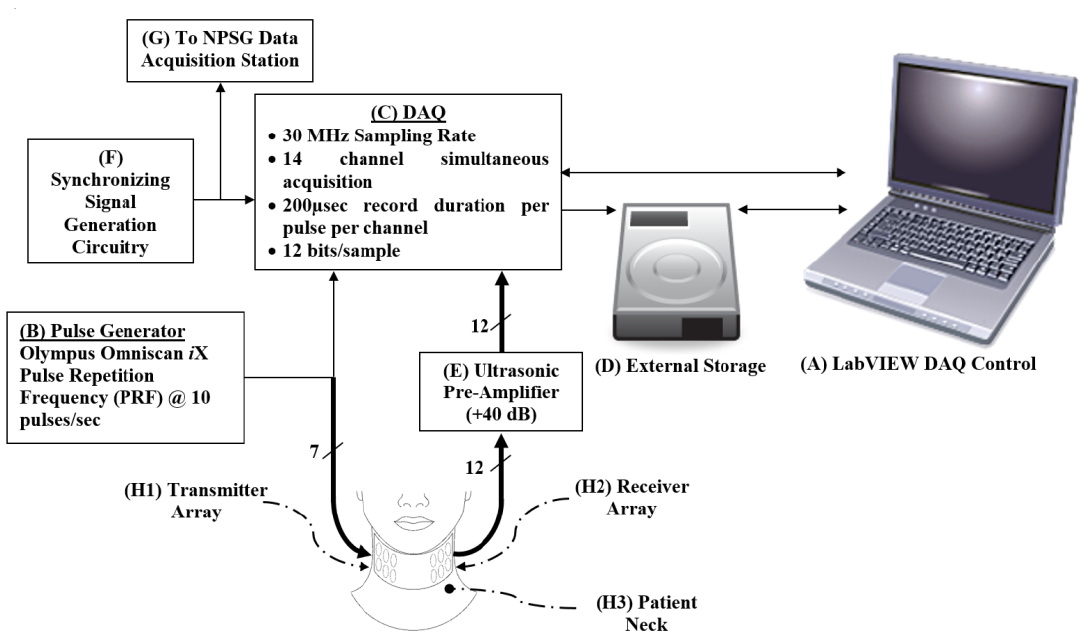
Figure 1. Schematic showing the hierarchy, control, and storage of the signals collected from the phantom. An Omniscan iX ( B ) generates pulses that are transmitted via a transducer array ( H1 ) to the patient’s neck ( H3 ) and is collected by the receiver array ( H2 ) on the opposite side of the neck. The received signal is amplified using the pre-amplifier ( E ). The DAQ ( C ) collects signals and is controlled by a LabVIEW program on the laptop ( A ). The onset of sampling is triggered by the function generator ( F ), which is also used to synchronize the other data collection stations during the night study ( G ). The collected data are streamed and stored in the external high-speed hard drive ( D ).